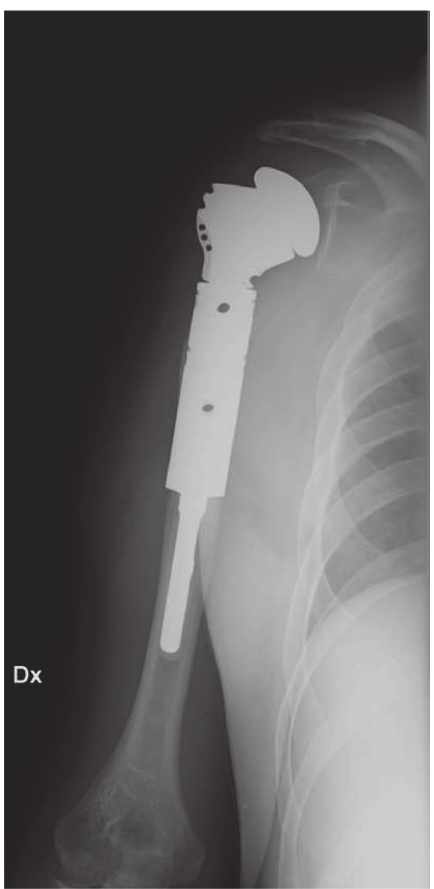
Figure 2: Anatomic megaprosthesis of proximal humerus implanted in our institution after massive bone resection due to resection of a malignant bone